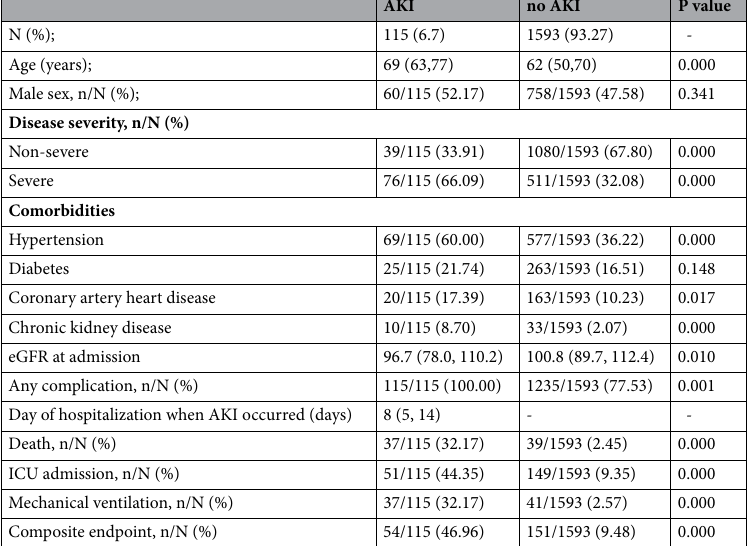
Table 4. Clinical characteristics and outcomes of COVID-19 patients with or without AKI.